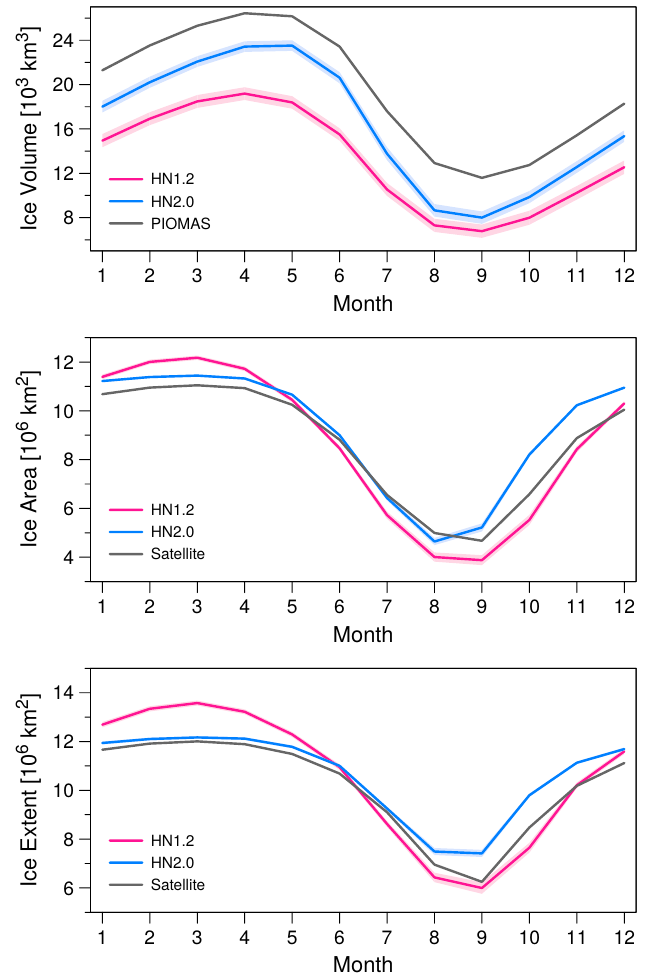
Figure 3. Mean seasonal cycle of sea-ice volume ( top ), sea-ice area ( middle ), and sea-ice extent ( bottom ). The red lines represent the ensemble mean of the 10-member ensemble of ERAI-driven simulations with HN1.2 and the very narrow red shaded areas the two-standard-deviation range of the ensemble. Analogously, the blue lines and blue shaded areas represent the HN2.0 ensemble. The gray lines represent sea-ice volume from PIOMAS and sea-ice area and extent from the SMMR and SSM/I-SSMIS satellite data. PIOMAS and satellite data were reduced to the NAOSIM domain. Data voids around the North Pole in the satellite data were filled with distance-weighted averages. All data refer to the period